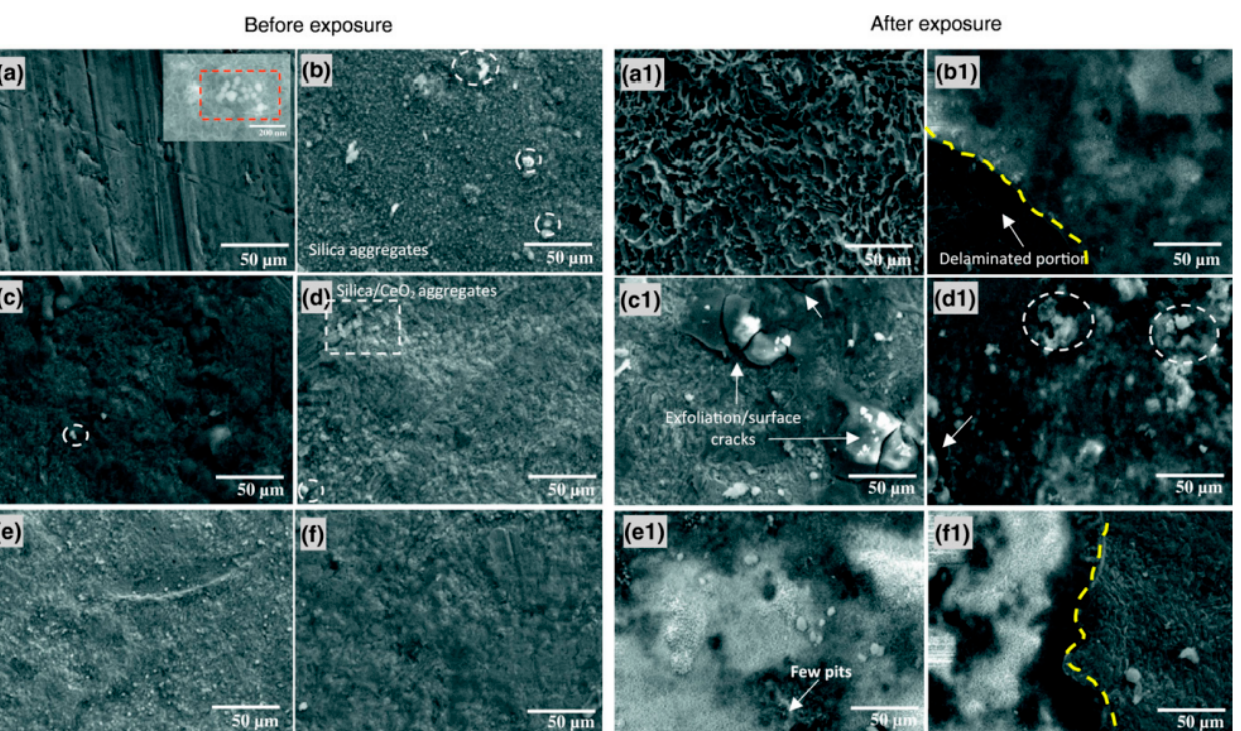
Figure 9. SEM micrographs of the coated mild steel before ( a – f ) and after ( a1 – f1 ) 14 days of exposure to aerated 0.6 wt% NaCl plus 0.6 wt% (NH 4 ) 2 SO 4 solution: ( a ) the metal etched surface without and ( b ) with the silane coating, the coating modified with ( c ) 0.25, ( d ) 0.50, ( e ) 1 and ( f ) 2 wt% CeO 2 . (Inset at ( a ): CeO 2 nanoparticle aggregates (25 nm particle size distribution)) [77].